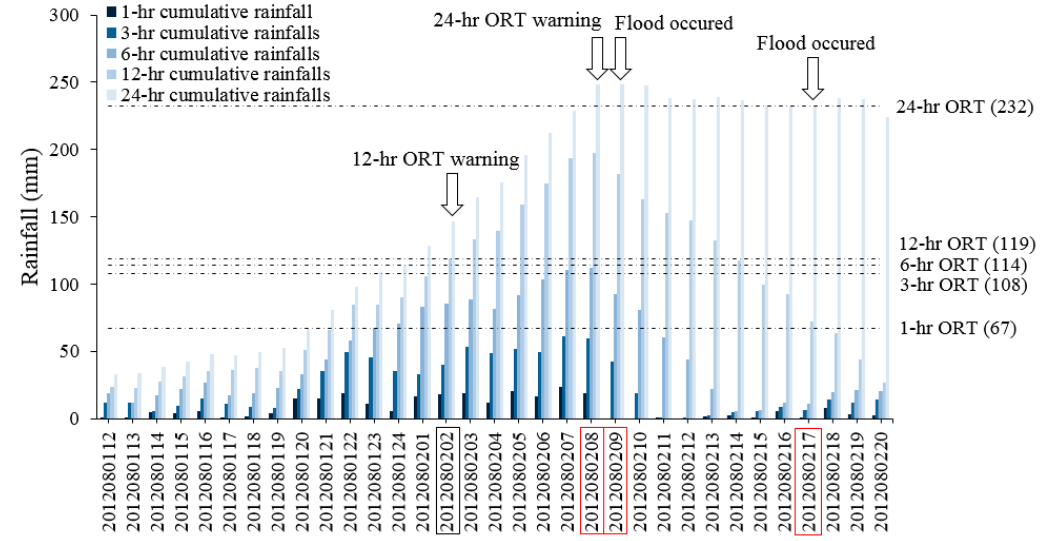
Figure 11. The warning process for the Gongguan (C1A730) rain gauge during Typhoon Soudelor in the Daan district.